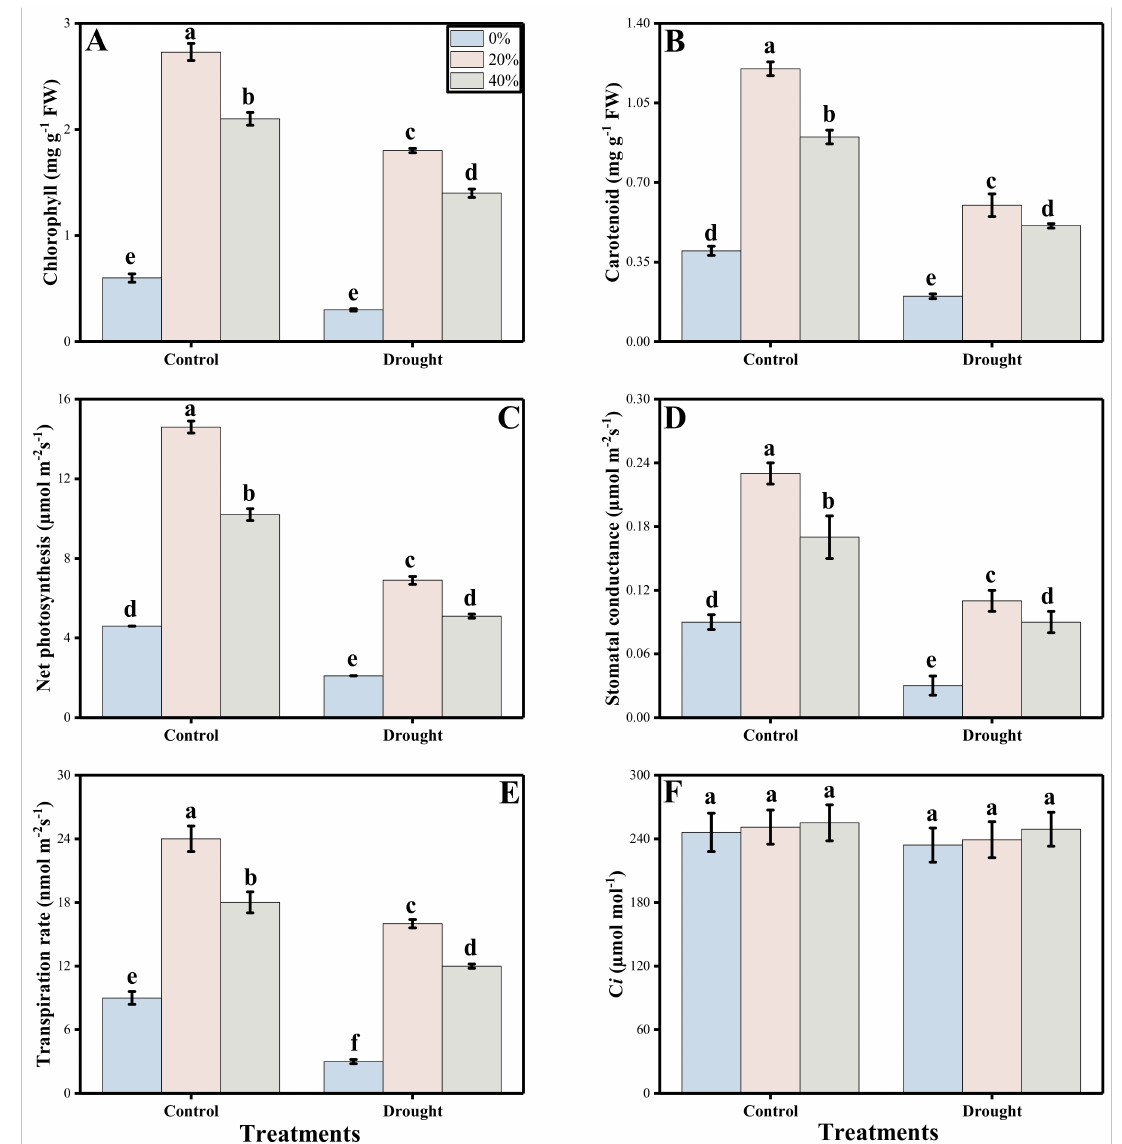
Figure 3. Effect of seed priming with Plantago ovata leaf extract on total chlorophyll contents ( A ), carotenoid contents ( B ), net photosynthesis ( C ) stomatal conductance ( D ), transpiration rate ( E ) and intercellular CO 2 ( F ) under water stressed and non-stressed environments in maize cultivar Cimmyt − Pak. Means sharing similar letter(s) within a column for each parameter do not differ significantly at p < 0.05. Data in the figures are means of three repeats ( n = 3) of just one harvest of Zea mays plants ± standard deviation (SD). Different lowercase letters on the error bars indicate significant difference between the treatments. Different treatments ( P. ovata extract) used in this study are as follows: 0% (0% P. ovata extract), 20% (20% P. ovata extract) and 40% (40% P. ovata